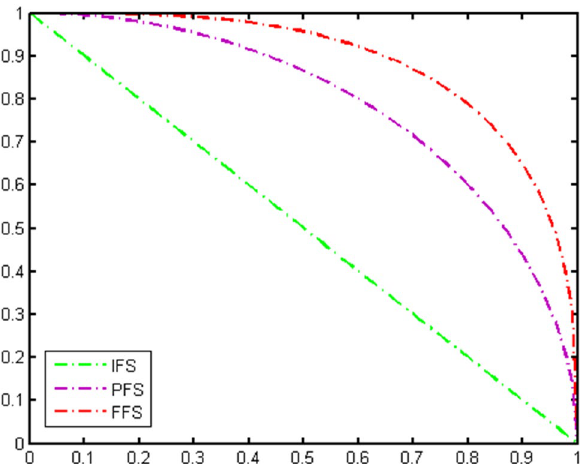
Figure 1. The pictorial representation of the IFS, PFS and FFS